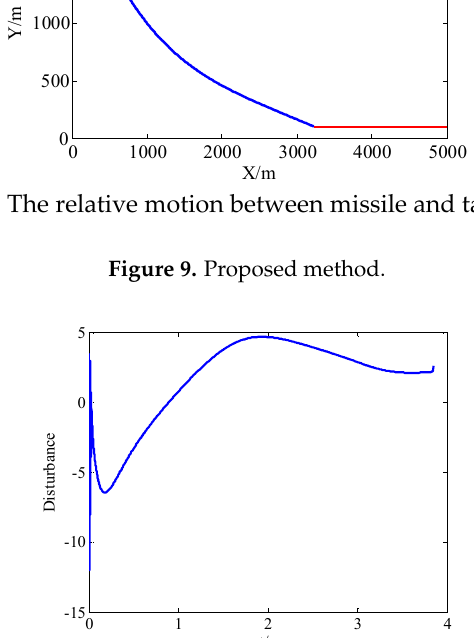
Figure 10. Projectile disturbance in real time. Sensors 2018 , 18 , x FOR PEER REVIEW